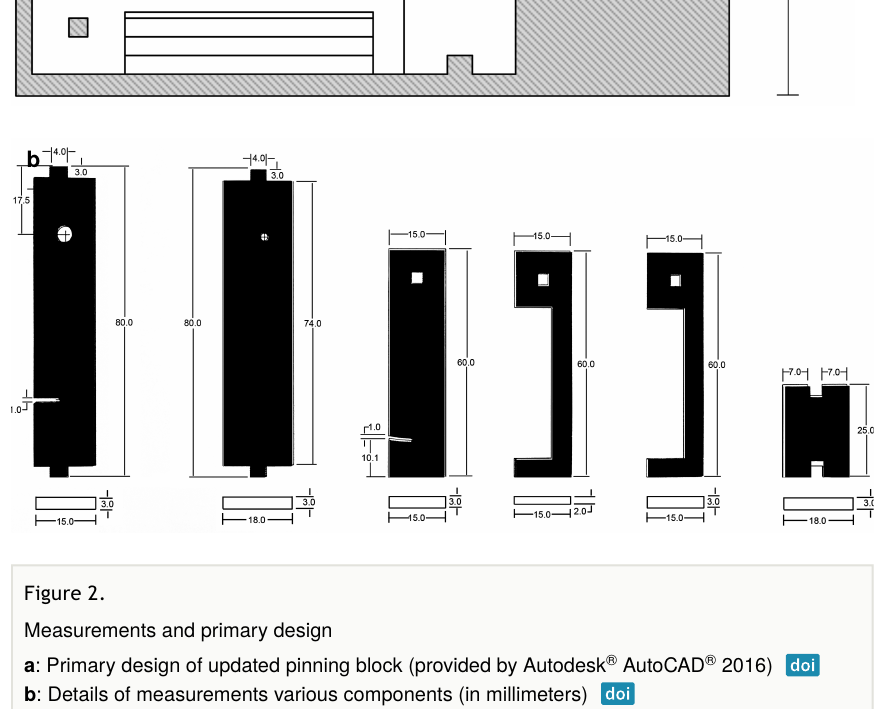
Figure 2. Measurements and primary design a : Primary design of updated pinning block (provided by Autodesk AutoCAD